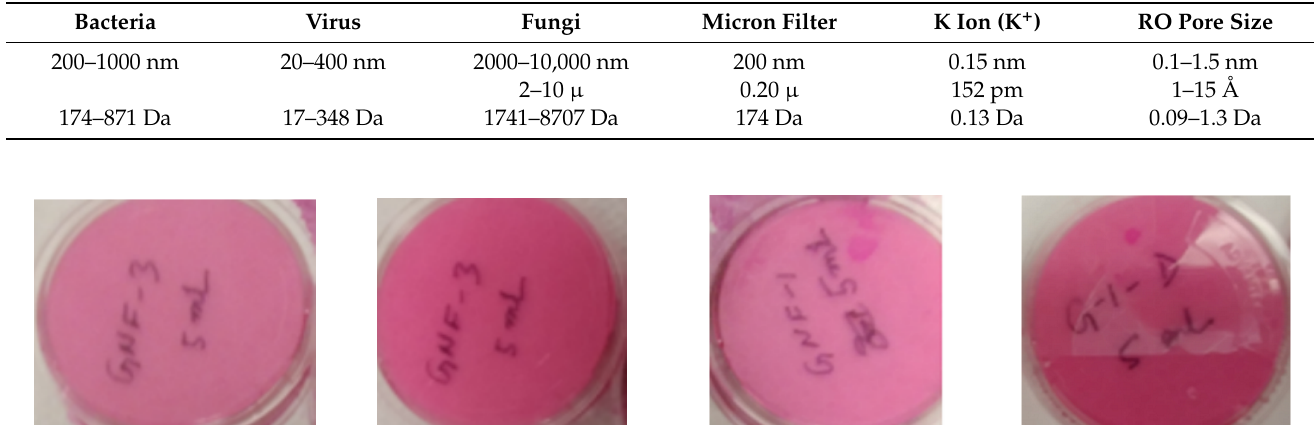
Table 1. Size range comparison of bacteria, virus, fungi, and K + with RO pores.